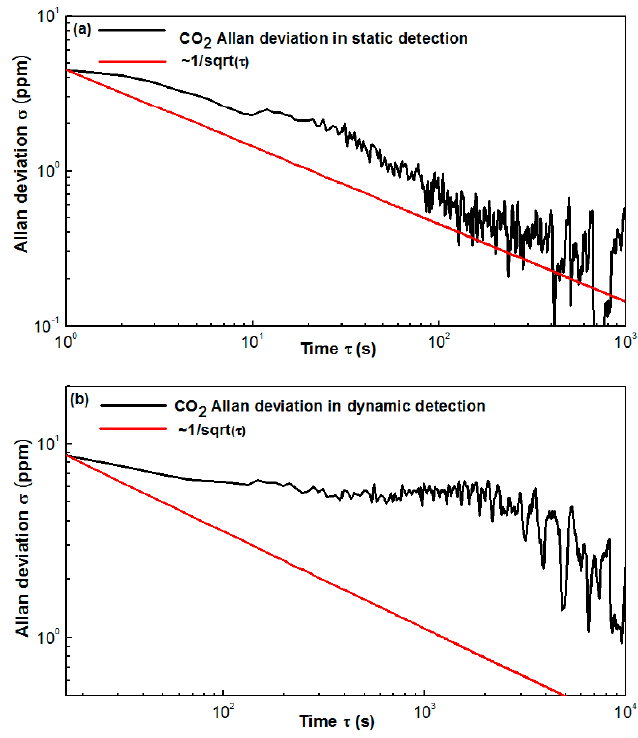
Figure 11. Allan deviation plot of the CO 2 sensor in ( a ) static state with a sampling interval of 1 s and ( b ) dynamic state with a sampling interval of 10 s.